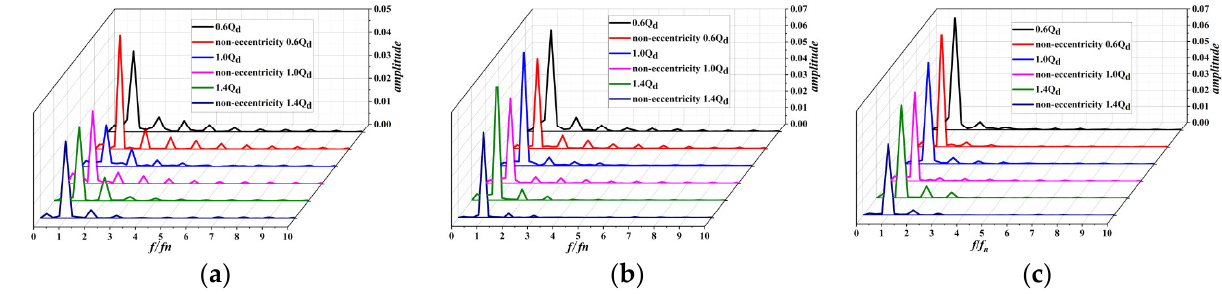
Figure 13. Frequency domain diagram of radial force on impeller under different flow conditions at rated speed. ( a ). F x . ( b ). F y . ( c ) F r .